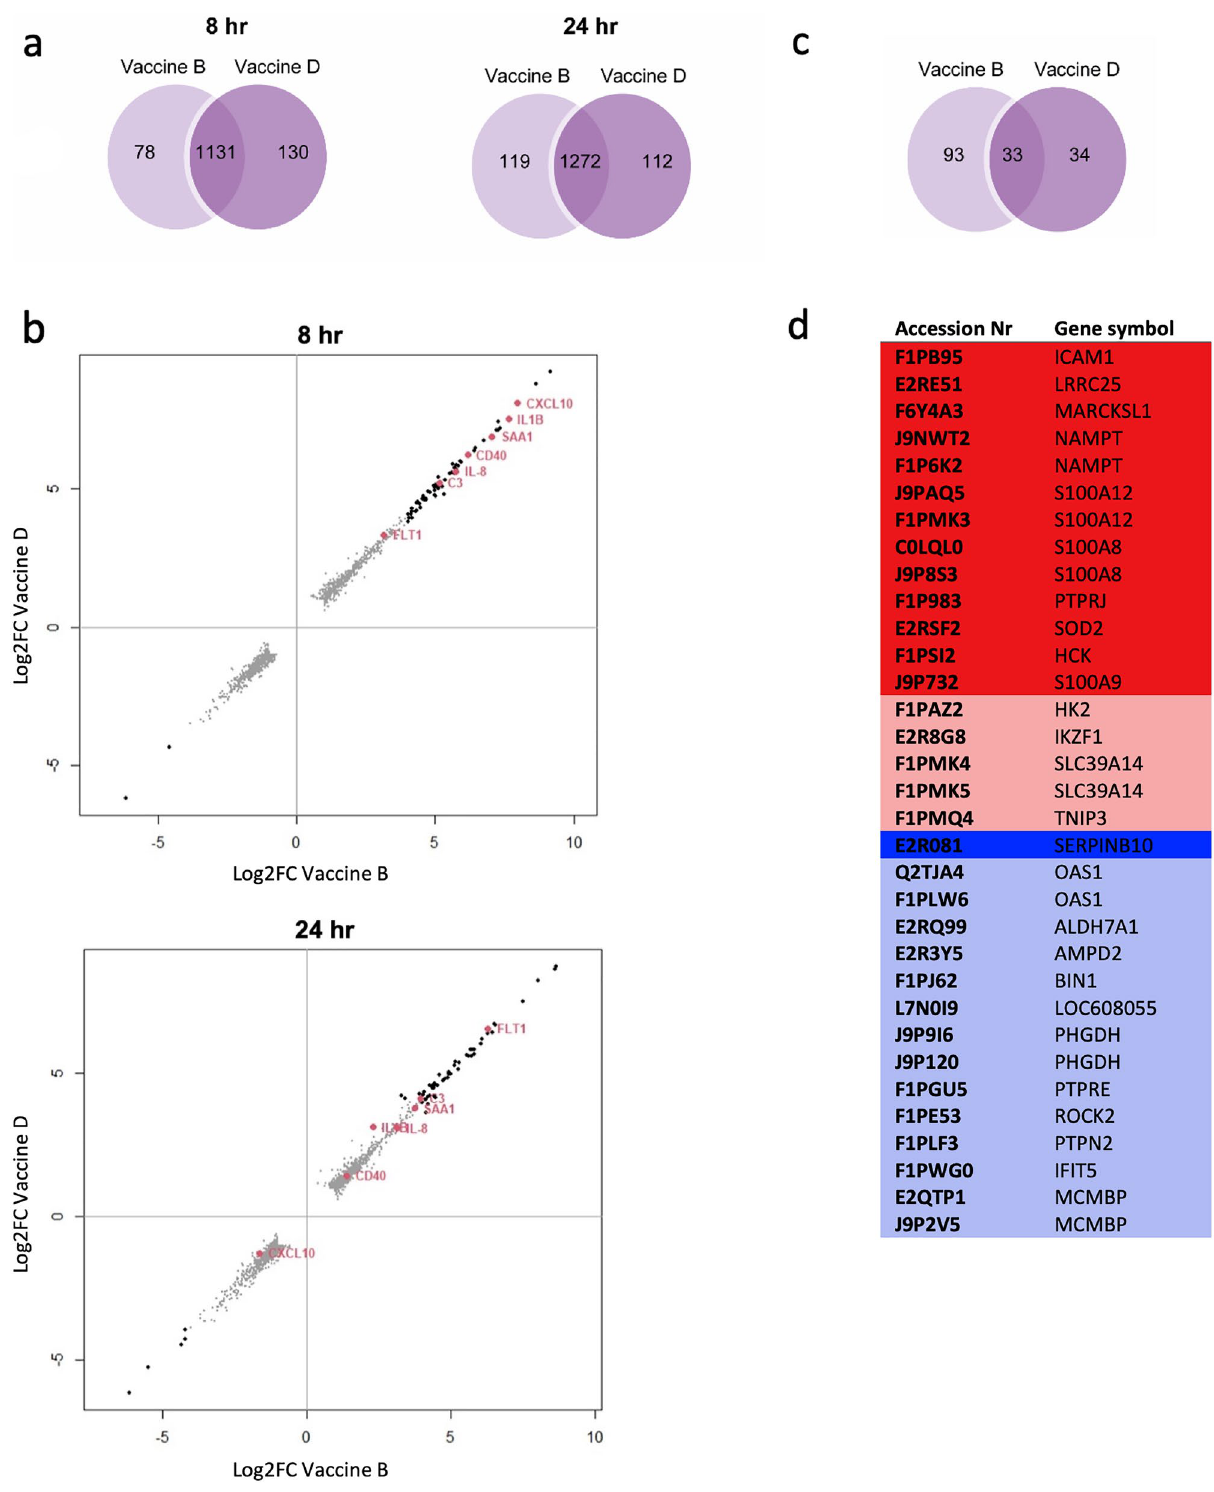
Figure 4. Comparison of DEGs and DEPs induced by bivalent Leptospira vaccines B and D. ( a ) Venn diagram of DEGs (FC ≥ 2; P < 0.001, FDR 5%) found after 8 and 24 h stimulation with bivalent Leptospira vaccines from two manufacturers (coded B and D) containing the inactivated L. interrogans serogroup Canicola or Icterohaemorrhagiae. ( b ) DEGs found after 8 and 24 h stimulation with bivalent vaccines B and D. DEGs with FC ≥ 2 are indicated in grey, while highly expressed DEGs with FC ≥ 16 are indicated in black. Additionally, some of the highly expressed DEGs are highlighted in red with the gene symbol next to it. ( c ) Venn diagram of DEPs found after 24 h stimulation with bivalent Leptospira vaccines B and D. ( d ) 33 DEPs induced by both vaccines correspond to 26 unique genes. Upregulated DEPs are shown in red and downregulated DEPs in blue. DEPs found with quantitative analysis are indicated with bright colors, while DEPs found with qualitative analysis are indicated with dim